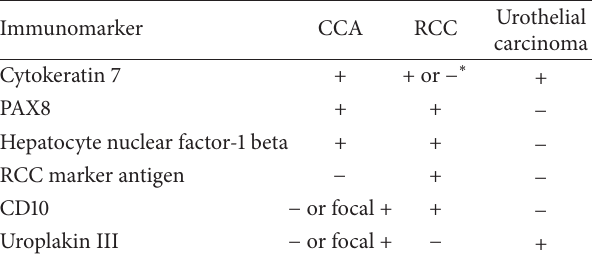
Table1:Summaryofimmunohistochemicalstainsinthedifferential diagnosis of clear cell adenocarcinoma in the urinary tract [5, 6, 10–